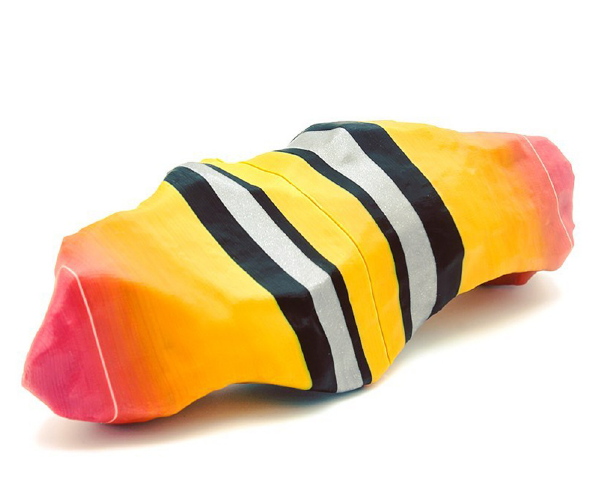
Figure 13: Mesolithic pick with dazzle di ff raction.